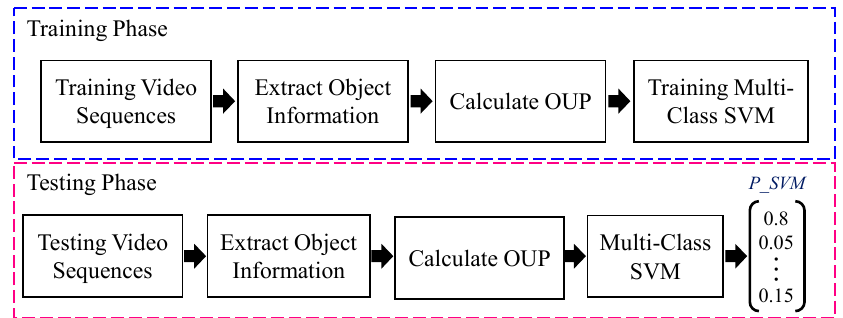
Figure 7. Illustration of training and testing phases of multi-class SVM using object usage probability (OUP) data.